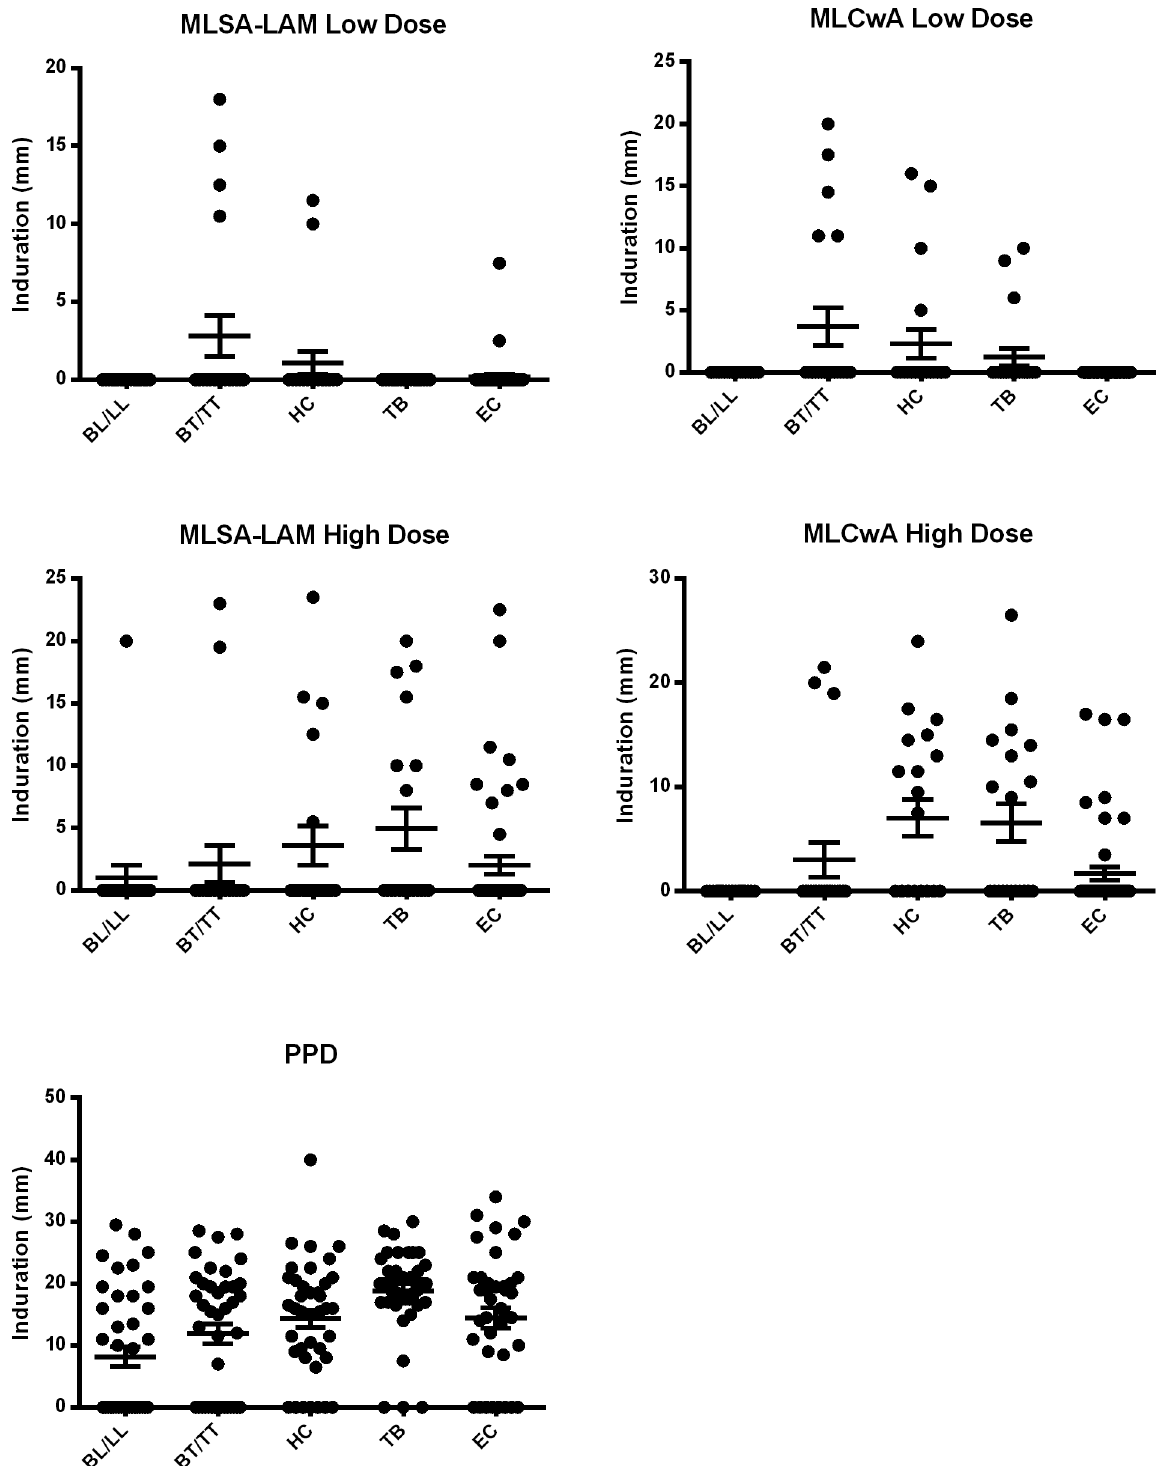
Figure 3. Dot plot of induration measurements. Induration results are provided across five subject groups, including BL/LL leprosy patients ( n =19 in low and n =20 in high dose group), BT/TT leprosy patients ( n =20), HC ( n =20), TB ( n =20), and ECs ( n =50). Low and high dose groups were combined to show PPD responses: BL/LL leprosy patients ( n =39) and all other groups ( n =40). Mean and standard deviation are shown.